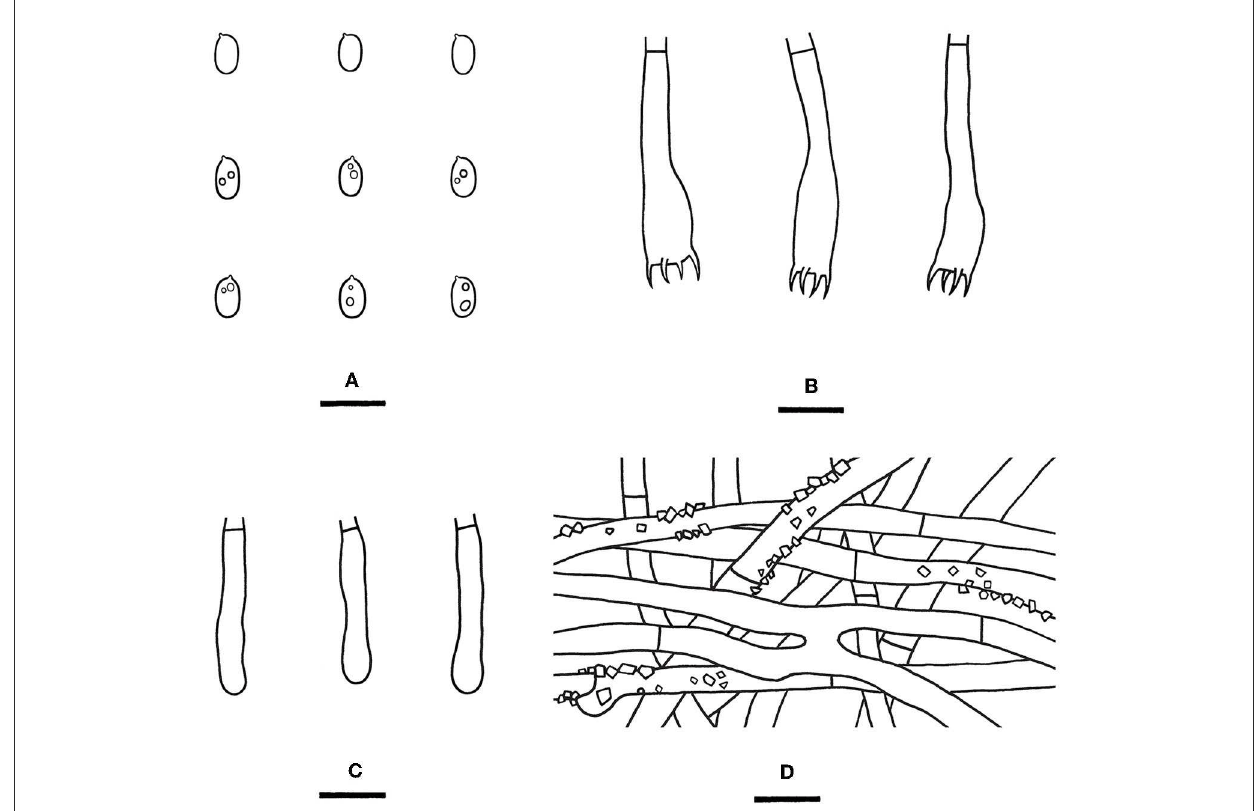
FIGURE11 Rhizochaete terrestris [from the holotype He 7713; scale bars: (A–D) = 10 µ m]. (A) Basidiospores; (B) Basidia; (C) Basidioles; (D) Hyphae from subiculum.